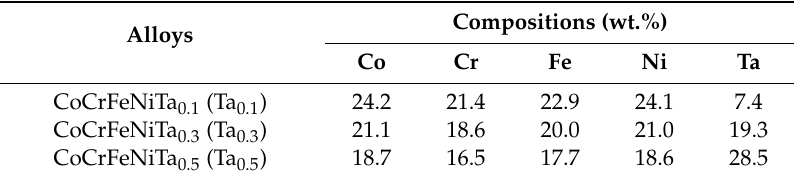
Table 1. Nominal compositions of as-cast CoCrFeNiTa x alloys analyzed by scanning electron microscope / energy dispersive spectrometer (SEM / EDS). Compositions Alloys